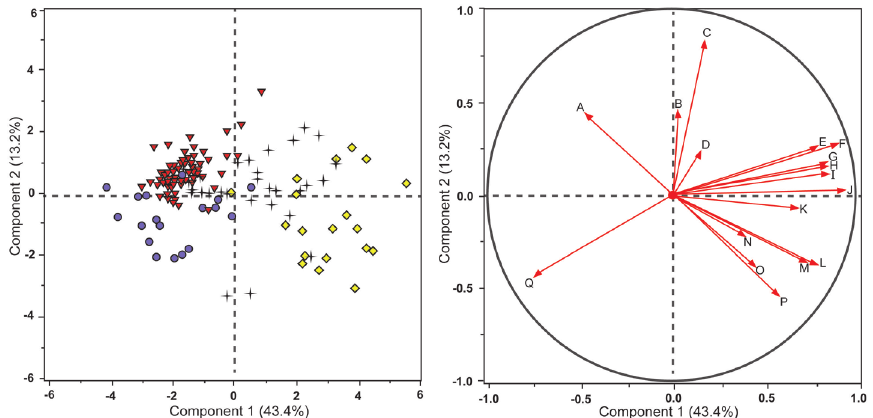
Figure 1. Principal components analysis score plot (Fig.1a, left) and loading plot (Fig. 1b, right) of characters and species in Table 1. Most heavily weighted characters labeled and indicated with red arrows in loading plot. Red triangles = S. jobsonii ; black crosses = S. eburneum ; purple circles = S. diversiflorum ; yellow diamonds = S. watneyi . Labels for loading plot are as follows: A Apical leaf depth of lobing B Basal leaf width C Basal leaf depth of lobing D Stem prickle length E Hermaphrodite calyx lobe length F Staminate calyx lobe length G Basal leaf length H Male corolla diameter I Hermaphrodite corolla diameter J Apical leaf length K Apical leaf surface area L Petiole length M Internode length N Apical leaf width O Plant height P Fruiting pedicel length Q Seed